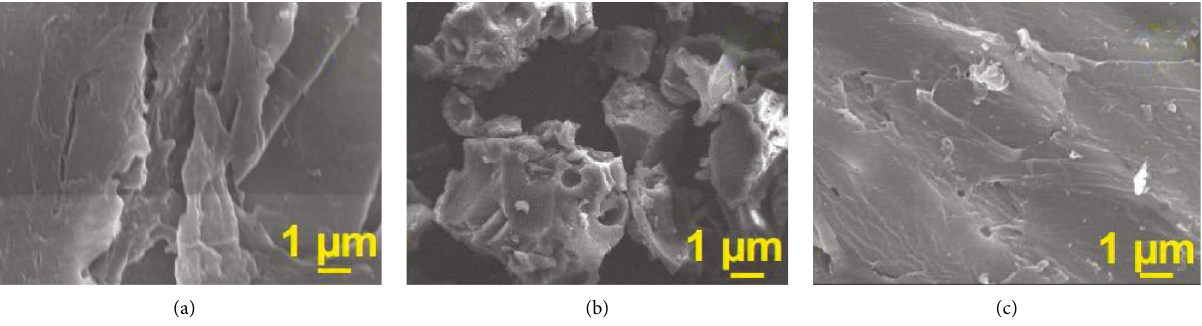
Figure 4: SEM image of (a) RADSP, (b) CADSP, and (c) Cr(VI)-CADS.